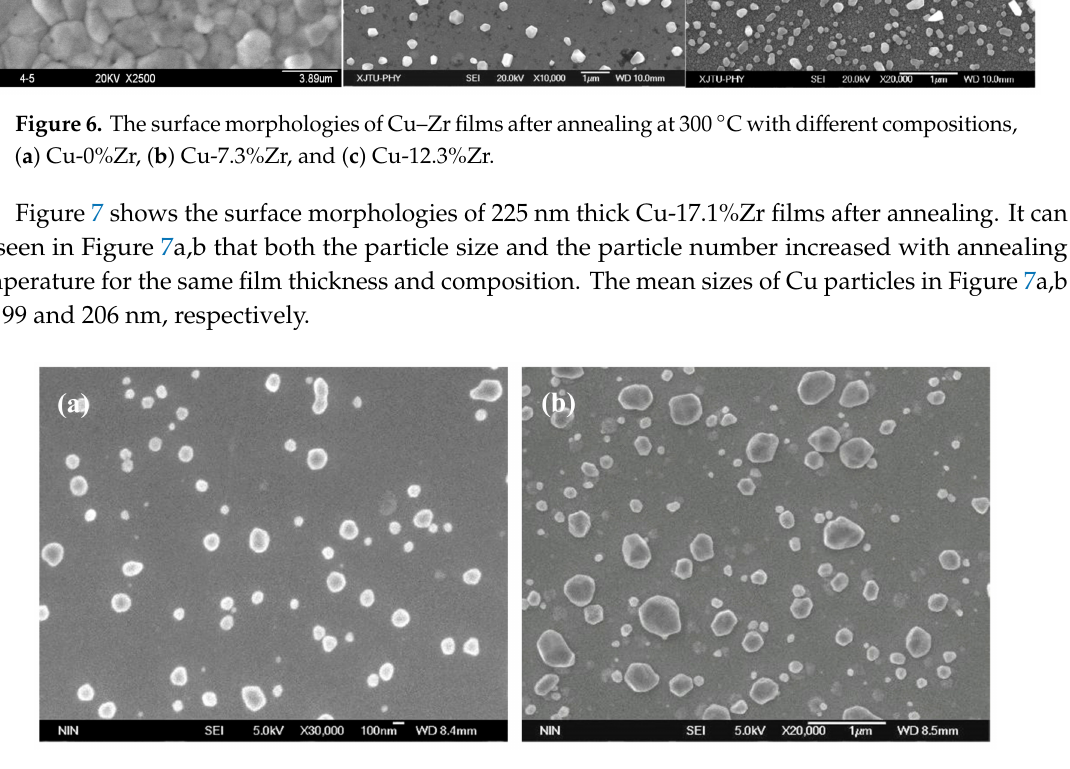
Figure 7. Surface morphologies of 225 nm thick Cu-17.1%Zr films after annealing at di ff erent temperatures: ( a ) 180 ◦ C, ( b ) 320 ◦